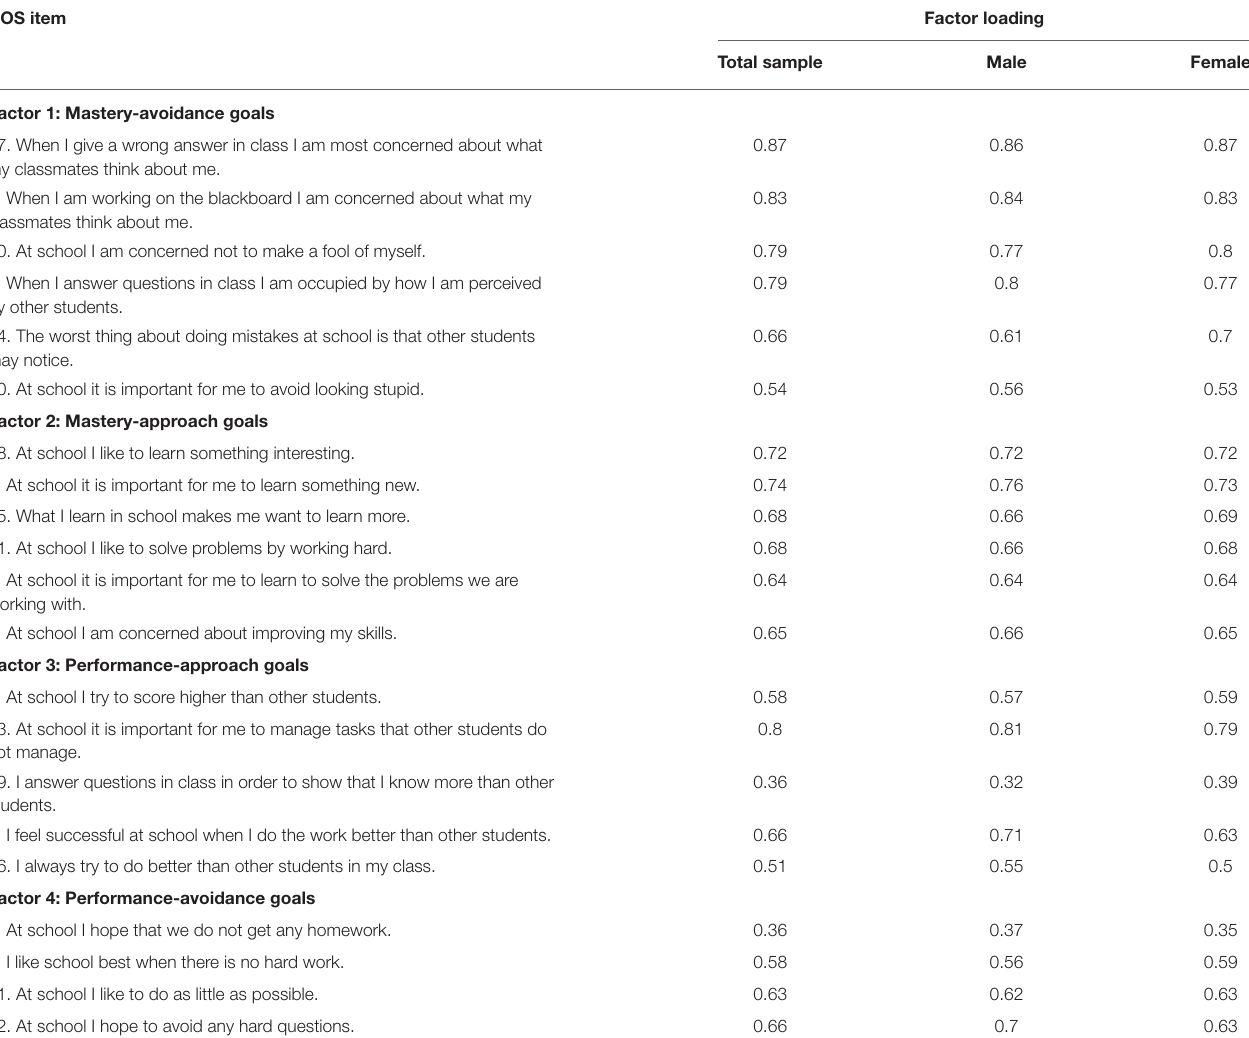
TABLE 3 | Results from the confirmatory factor analysis with the standardized factor loadings of the Goal Orientation Scales obtained in the total sample and according to